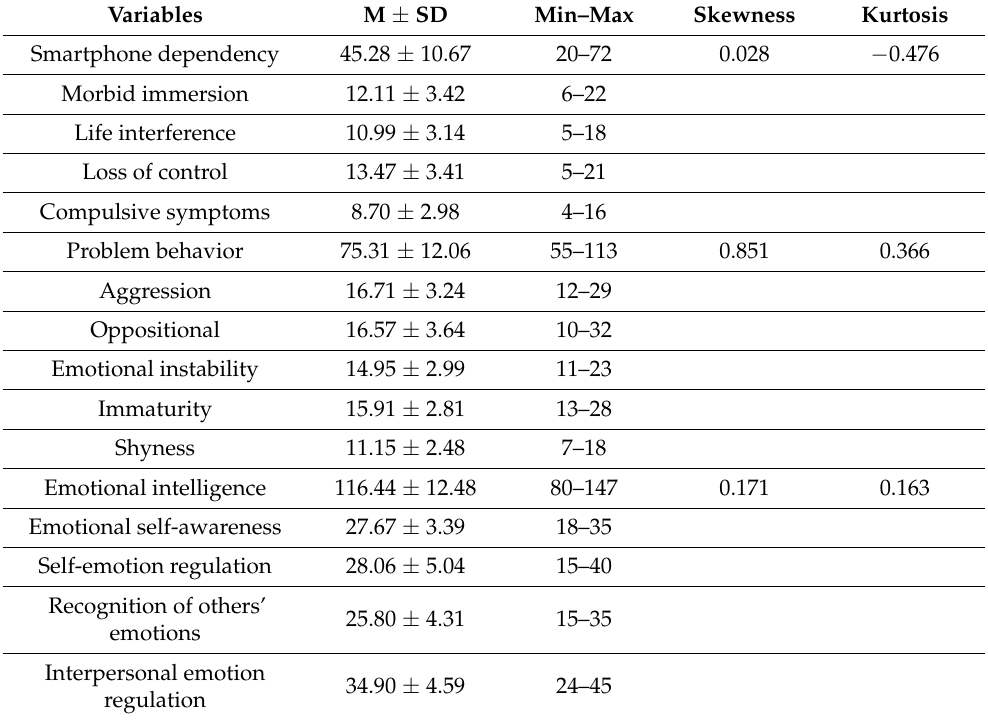
Table 2. Mother’s smartphone dependency and preschooler’s problem behavior and emotional intelligence. ( n =